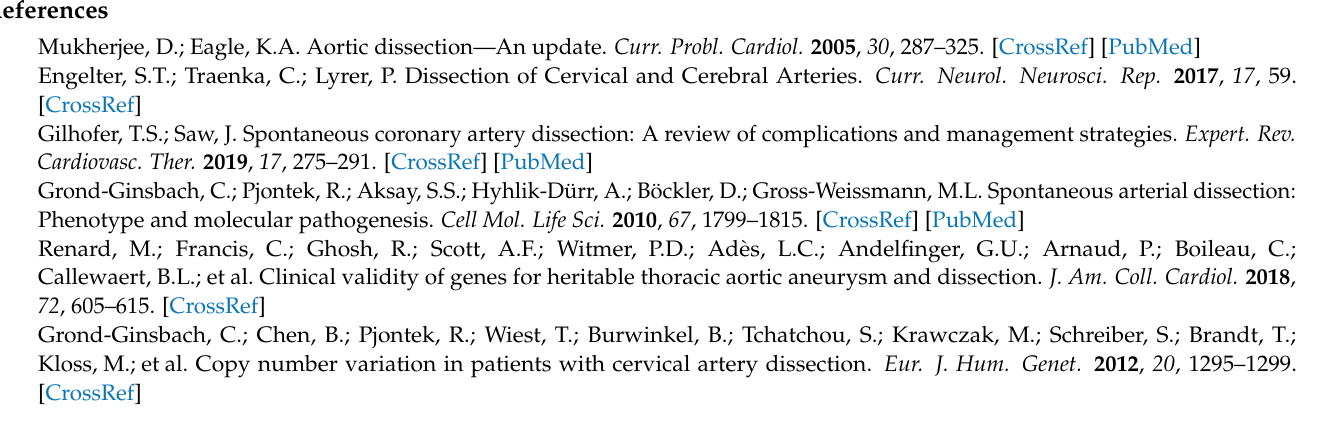
Figure 2 preparation and embryologic expertise. S.D., J.M., N.D., C.P.S. and D.B. contributed